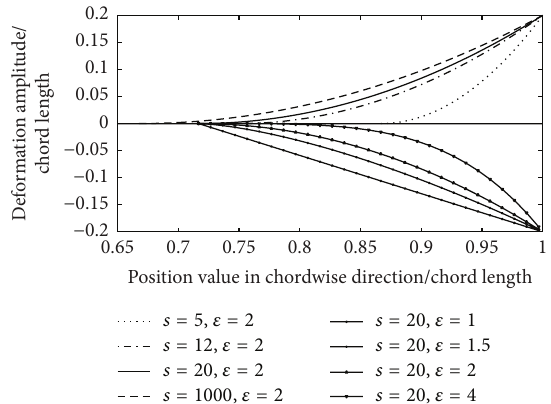
Figure 2: Deformation of caudal peduncle under various 𝑠 and 𝜀